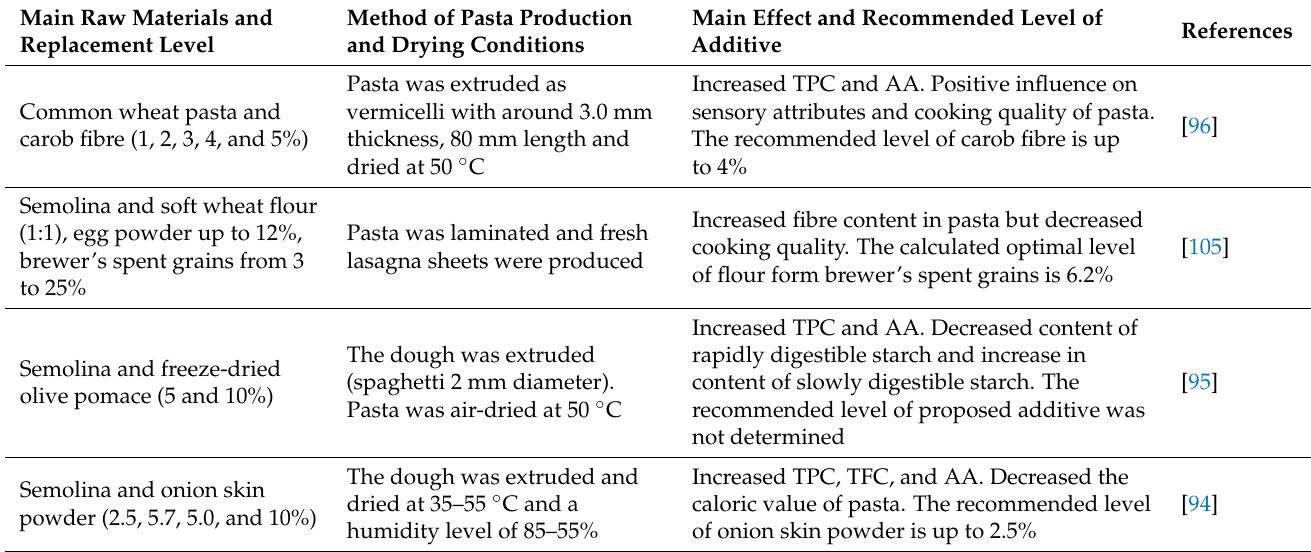
Table 5. Effect of pasta fortification with different raw materials rich in